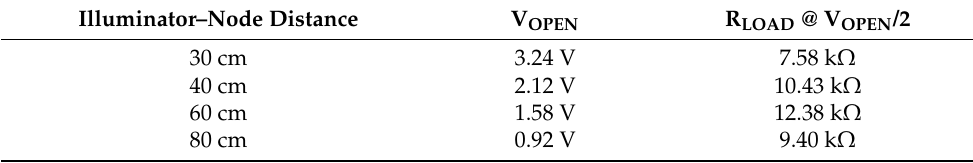
Table 2. Measurements of the values of the load emulating the bq25570 MPPT operations. Illuminator–Node